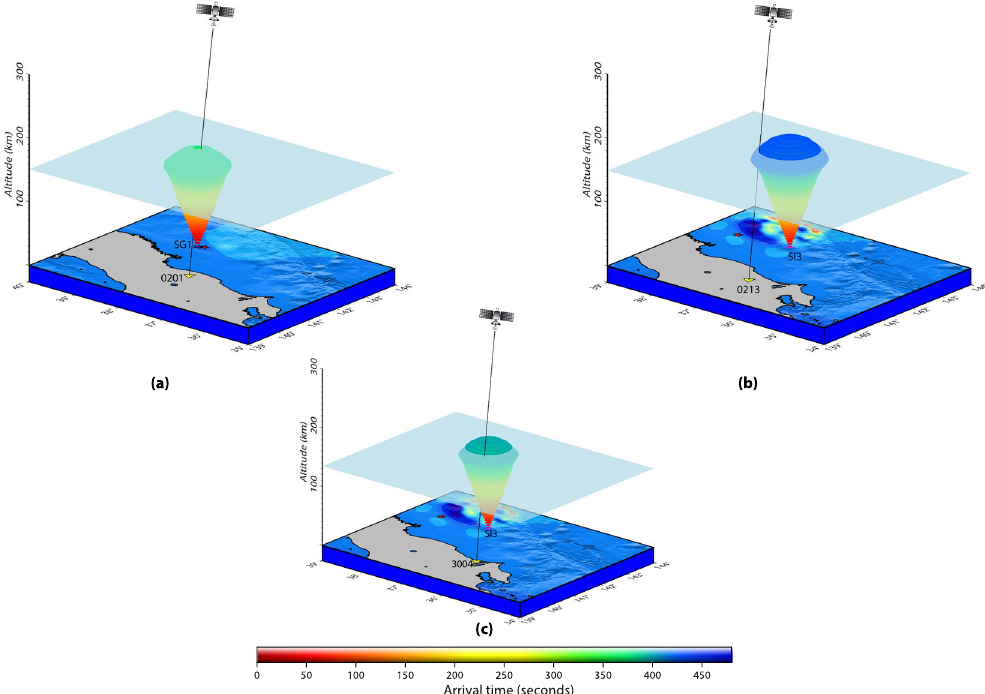
Figure 6. Identification of seismic sources for CIP observed by PRN 26 from ( a ) 0213, ( b ) 3004, and ( c ) 0201 GPS stations. The first interaction of PRN 26 LOS from 0213 and 3004 GPS stations occurred with the seismo- acoustic rays evolving from SI3 source while that from 0201 station occurred with the rays from SG3 source. The interaction time and altitude are respectively ~532 s and ~149 km in case of 0213 station, ~498 s and ~135 km in case of 3004 station, and ~466 s and ~152 km for 0201 station. Other information is the same as Fig. 3. The figure is prepared using the GMT 5.4.1 43